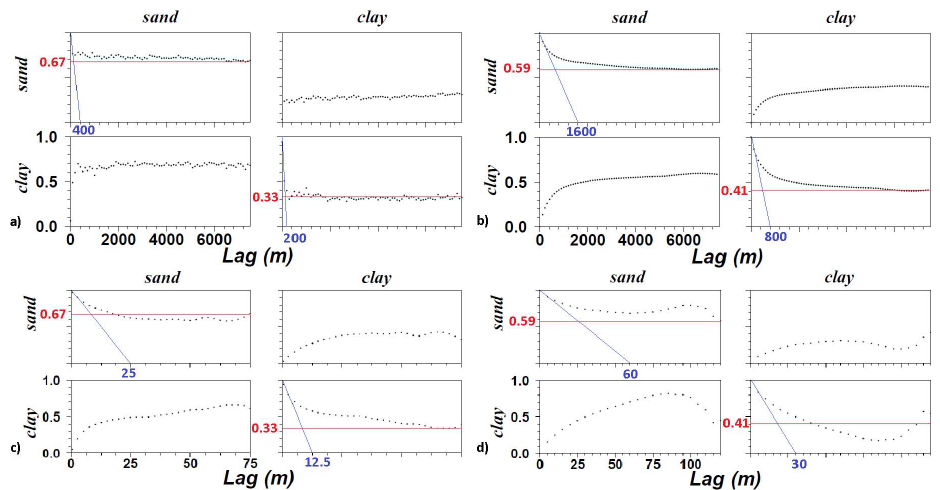
Fig. 3. Transition probability of Quaternary sediments. (a) Borehole data in lateral direction; (b) data from 3-D training image (TI) in lateral direction; (c) borehole data in vertical direction; (d) data from 3-D TI in vertical direction.